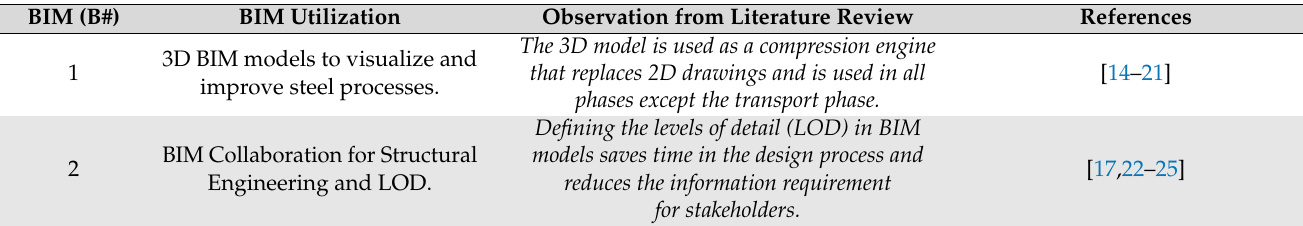
Table 1. The application of BIM based on